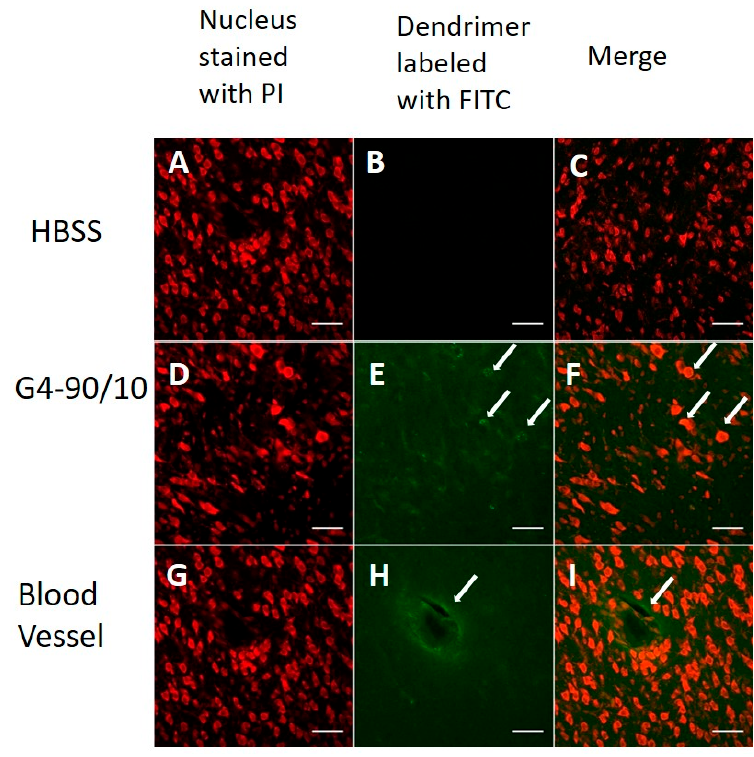
Figure 6. Confocal images of dendrimer in the brain when injected through the carotid artery. Neurons and glial cells labeled with propidium iodide (PI) stain (red— A , D , G ), Hank’s balanced salt solution (HBSS) control and merge ( B , C ), G4-90/10 infecting cells (arrow; E ) and merge (arrow; F ), G4-90/10 surrounding the blood vessel (arrow; H ) and merge (arrow; I ). All images were taken at 40× magnification using Olympus BX50 Upright Microscope (Olympus, Shinjuku, Tokyo, Japan). Scale bar: 100 μ m.